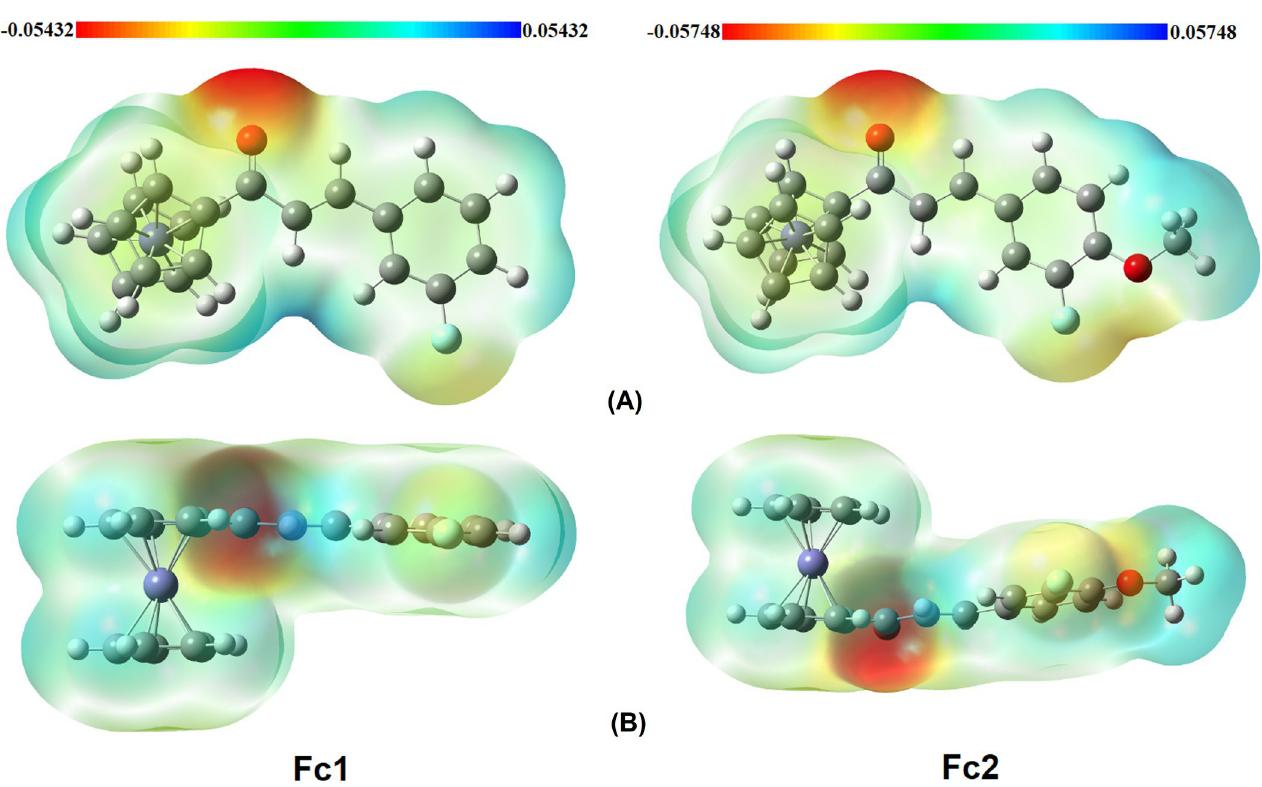
Fig 9. MEP plot of Fc1 and Fc2. (A) From the top view (B) From the side view.